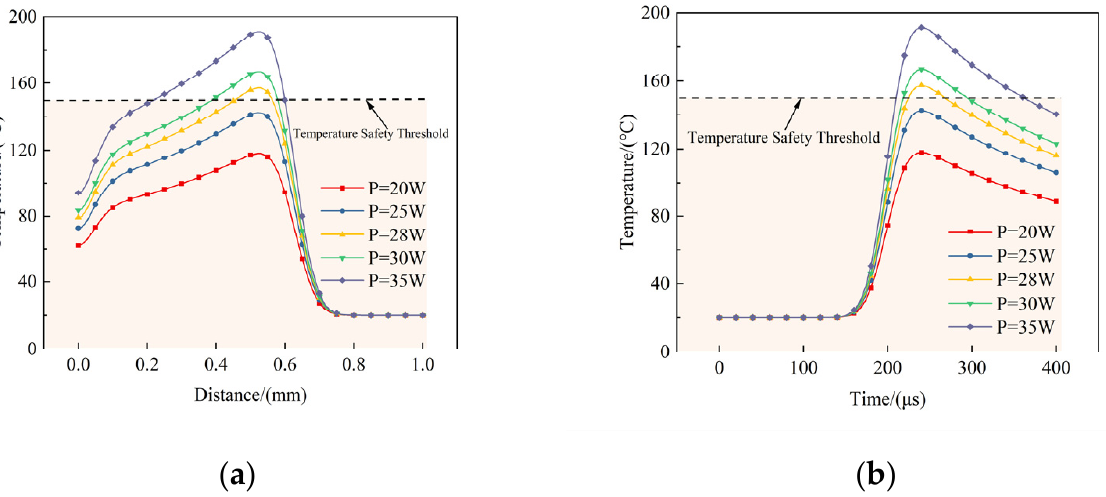
Figure 3. ( a ) X-axis temperature distribution of the porcelain insulator surface under different powers; ( b ) Temperature variation of the insulator surface center point under di ff erent powers.